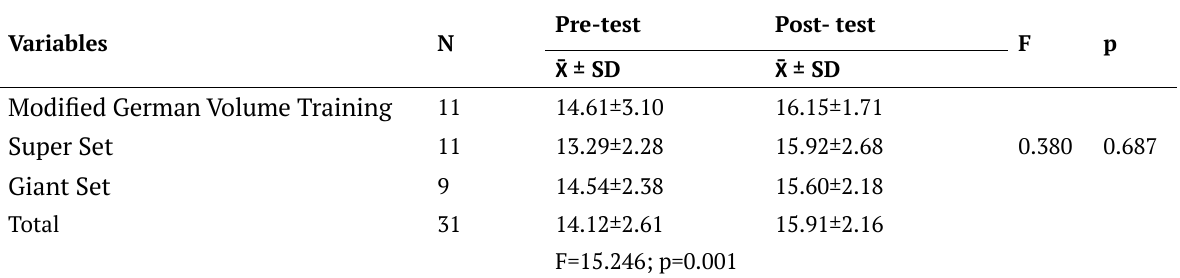
Table 6. Pre-test and post-test comparison of deltoid area values of the groups